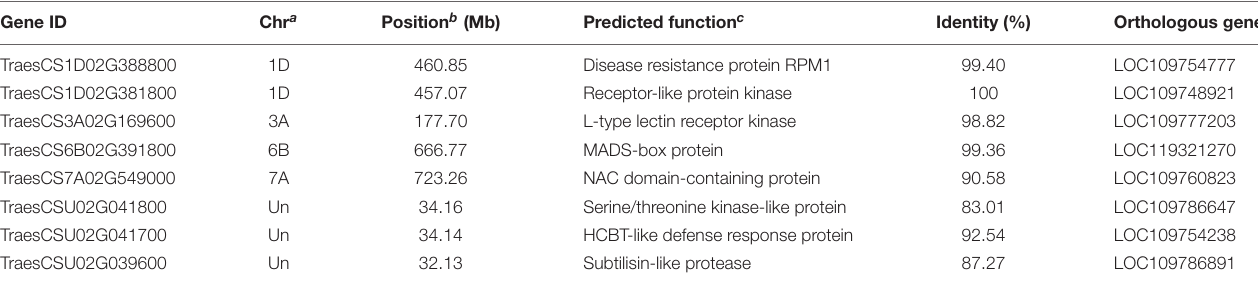
TABLE 6 | Candidate genes for Fusarium seeding blight